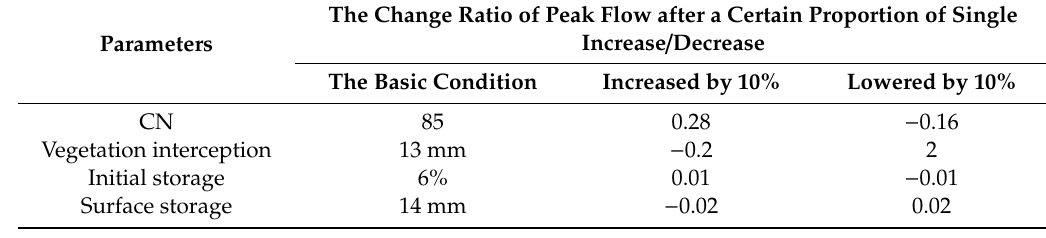
Table 4. Parameters sensibility analysis for HEC-HMS simulations of hydrological